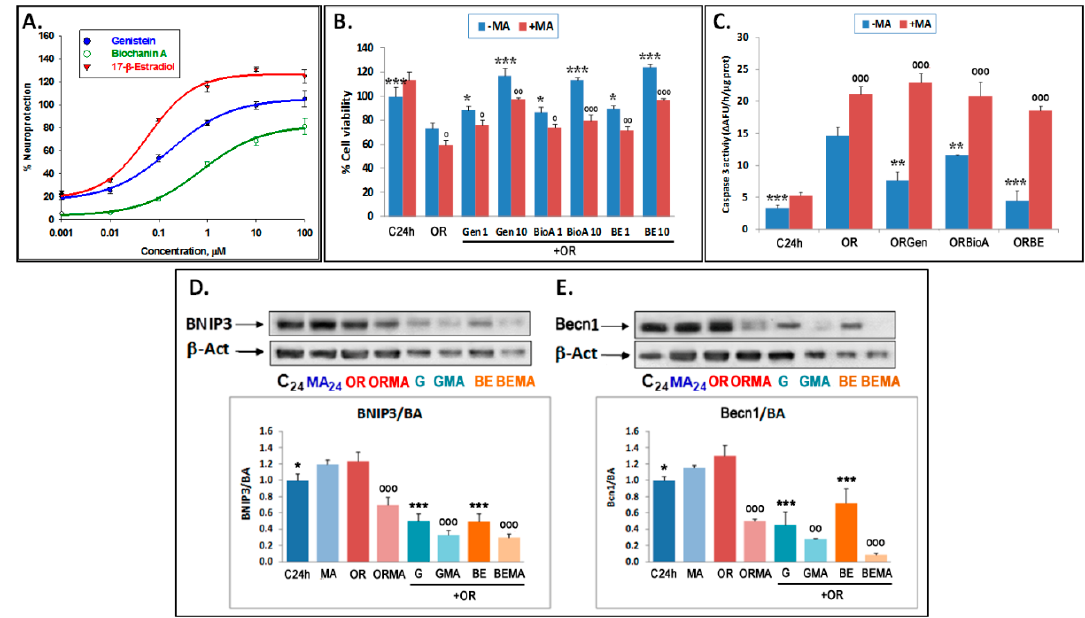
Figure 3. Neuroprotective e ff ect of phytoestrogens on the decrease in cell viability, apoptosis, and autophagy (BNIP3 and Beclin 1 expression) induced by OGDR in cortical neuron cultures: E ff ect of 3-MA. ( A ) Dose–response curves of the neuroprotective e ff ect a ff orded by 0.001–100 µ M concentrations of phytoestrogens on the decrease in neuronal viability (metabolic activity) induced by OGDR (OR). The data are the means ± SEM of three determinations, each one performed in triplicate. Data analysis was performed with SigmaPlot 11 (see Section 2). ( B ) E ff ect of 5 mM 3-MA on the neuroprotective e ff ect of Gen, BioA, and 17 β E at 1–10 µ M concentrations. Cell viability (metabolic activity) was measured by the XTT method. Data are expressed as percentages of cell viability of basal controls (100%) and are mean ± SEM of three experiments, each of which was performed in triplicate. In ( B ) the statistics compare the e ff ect of the indicated compounds over OR alone (***) or the e ff ect of 5 mM 3-MA treatments over their respective controls in the absence of this compound ( ooo ) at o p < 0.05, oo p < 0.01, ooo / *** p < 0.001 (one-way ANOVA test). ( C ) Neuroprotective e ff ect of phytoestrogens on the increase in apoptosis induced by OGDR. E ff ect of 5 mM 3-MA on the neuroprotective e ff ects of Gen, BioA, and BE at 1 µ M concentration. CASP 3 activity was measured as indicated in Material and Methods. Data are expressed as ∆ AFU / h / µ g protein and are mean ± SEM of three experiments, each of which was performed in triplicate. Statistics comparing the e ff ect of indicated compounds over OR condition alone (***) or the e ff ect of 5 mM 3-MA treatments over their respective controls in the absence of this compound ( ooo ) at ** p < 0.01, *** / ooo p < 0.001 (one-way ANOVA test) are shown. ( D , E ) E ff ects of 1 µ M genistein (Gen) or 17- β -estradiol (BE) on the expression of BNIP3 and Becn1 proteins. Upper panels show representative Western blots and lower panels represent the quantitative analysis of data expressed as ratios over basal control and are mean ± SEM of three experiments, each of which was performed in duplicate. Statistics comparing the e ff ect of OR alone over its control and in the presence of phytoestrogens (***) and the e ff ect of 5 mM 3-MA in each condition versus respective controls in the absence of this compound (ooo) (* p < 0.05, oo p < 0.01, *** / ooo p < 0.001; one-way ANOVA test) are shown. G: 1 µ M genistein; GMA: 1 µ M genistein plus 3-MA; BE: 1 µ M 17- β -estradiol; BEMA: 1 µ M 17- β -estradiol plus